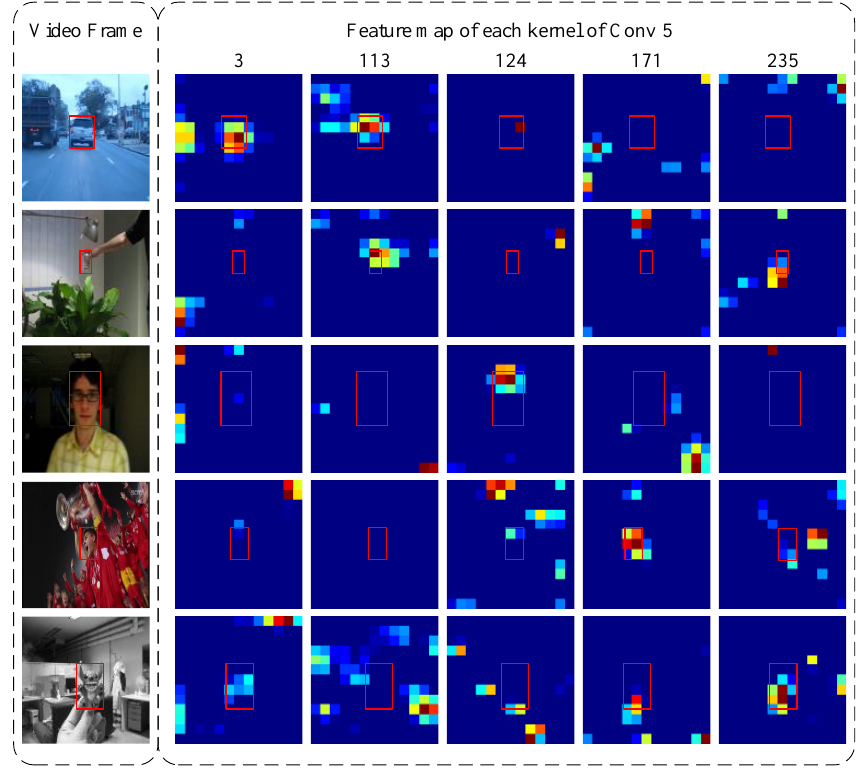
Figure 2. The response of different convolutions towards the object in the Conv5 convolution layer. As shown in Figure 2, the objects and environments in different video sequences perform differently for each convolution kernel in the Conv5 convolutional layer. The response position of the “blurcar1” sequence in the third convolution kernel